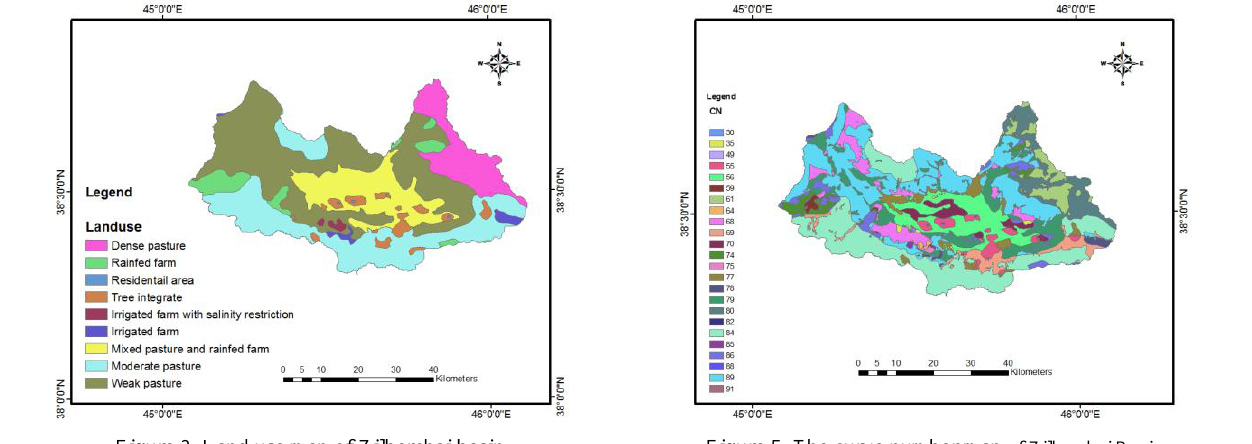
Figure 3. Land use map of Zilberchai basin